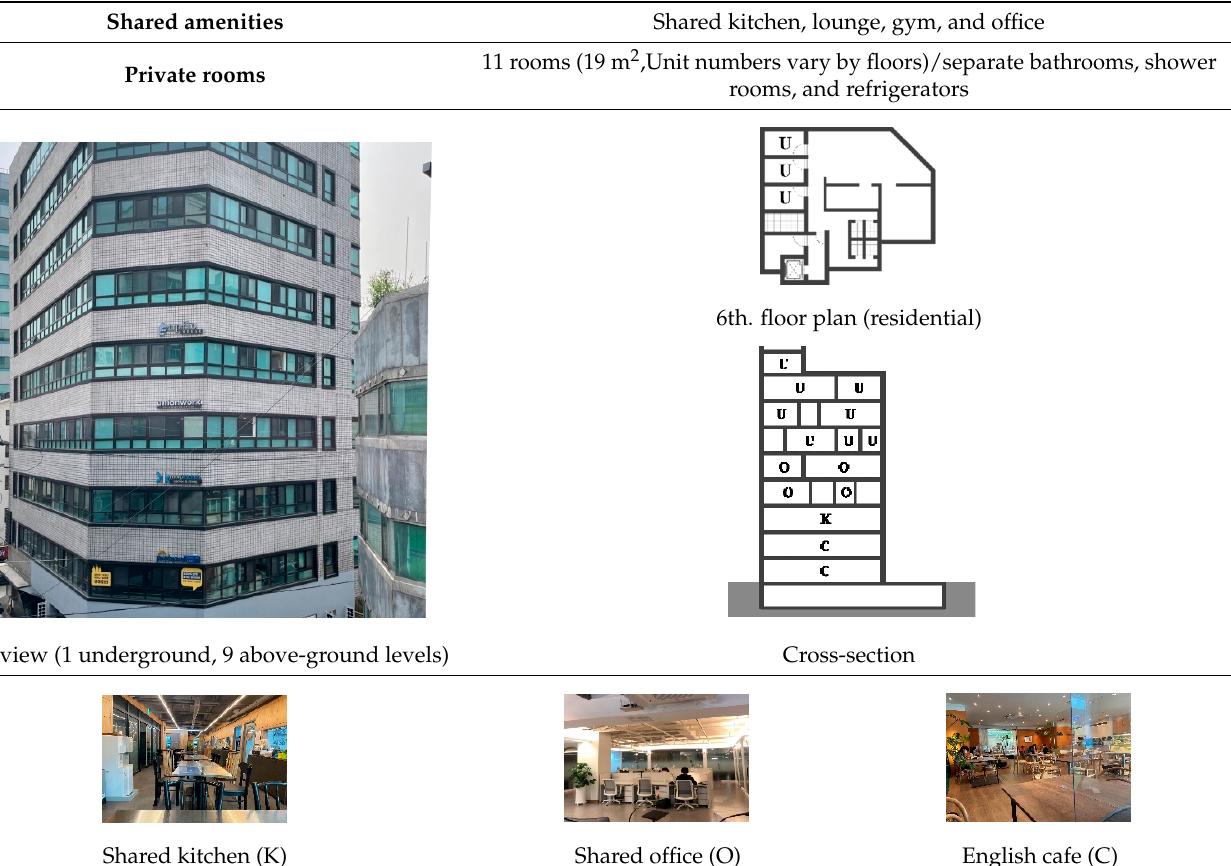
Table 8. Union town [27].